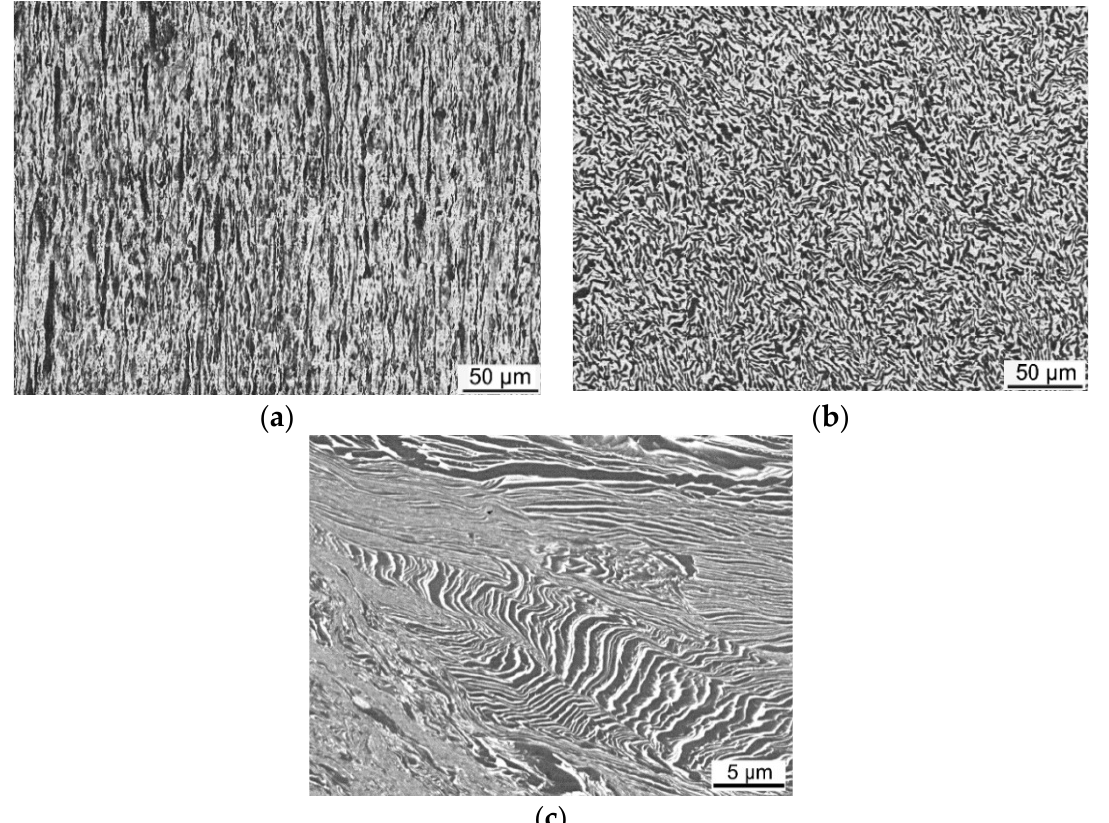
Figure 5. Structures of Ti6Al4V samples: sample 2—axial cut from rod subjected to hot forward extrusion ( a ); sample 3—transversal cut from rod subjected to hot forging ( b ); sample 4—transversal cut from rod subjected to three-step cold stamping ( c ).